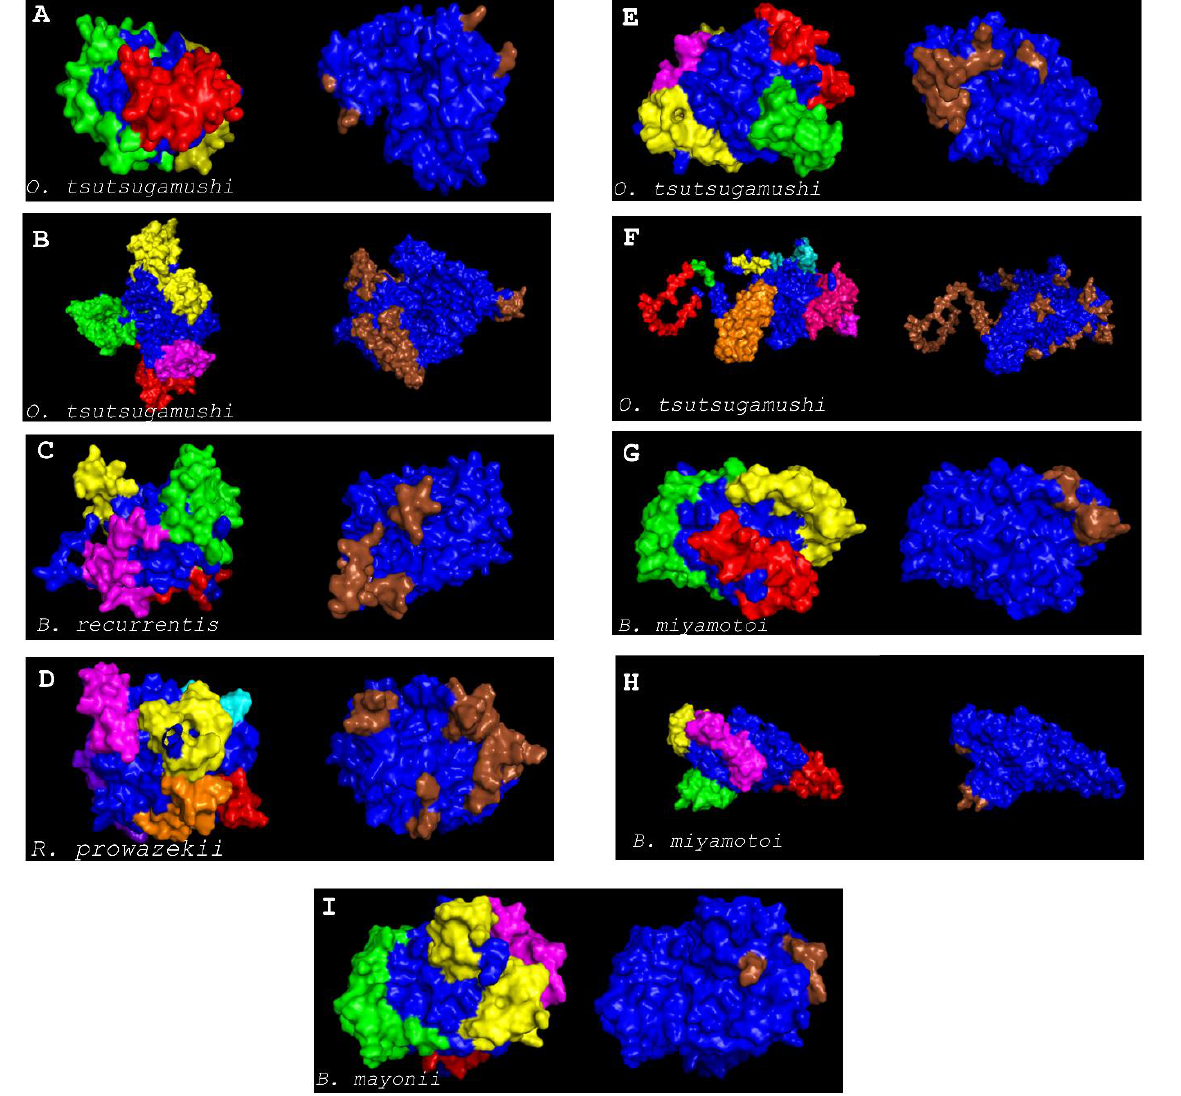
Figure 5. The three-dimensional structure of the protein was predicted by I-TASSER and Discon- tinuous epitope prediction of the putative epitopes identified by ElliPro (left and with colored epitopes) and DiscoTope (right and epitopes in brown). ( A ) UDP-N-acetylmuramate dehydrogen- ase ( Orientia tsutsugamushi ; WP_011944569.1), ( B ) Type IV secretion system protein ( O. tsutsuga-